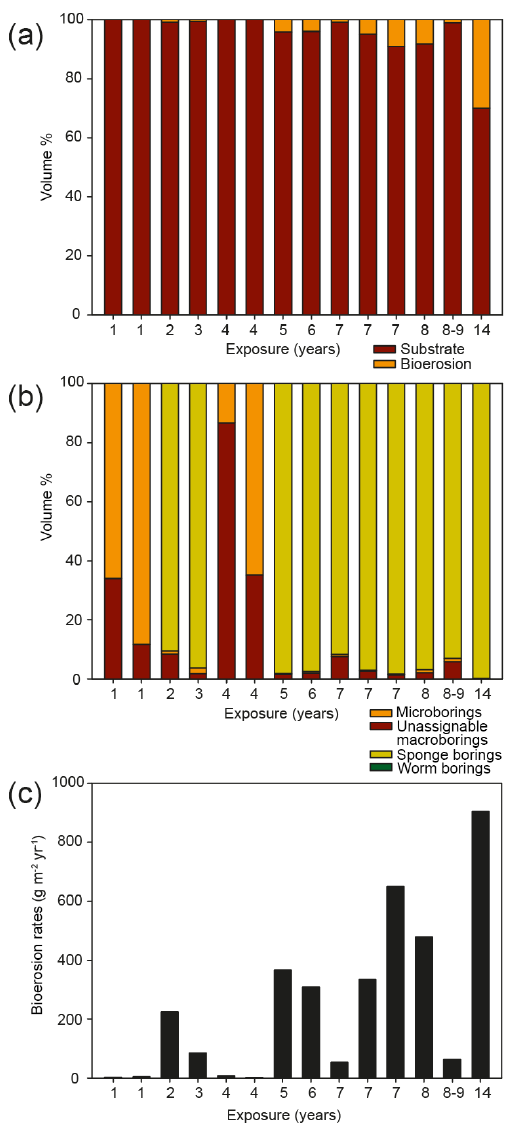
Figure 7. (a) Proportion of retained substrate vs. internal bioero- sion in the scanned blocks, (b) proportional contribution of the dif- ferent groups of boring organisms to the internal bioerosion in A, and (c) internal bioerosion rates (gm − 2 yr − 1 ) measured in experi- mental substrates during the